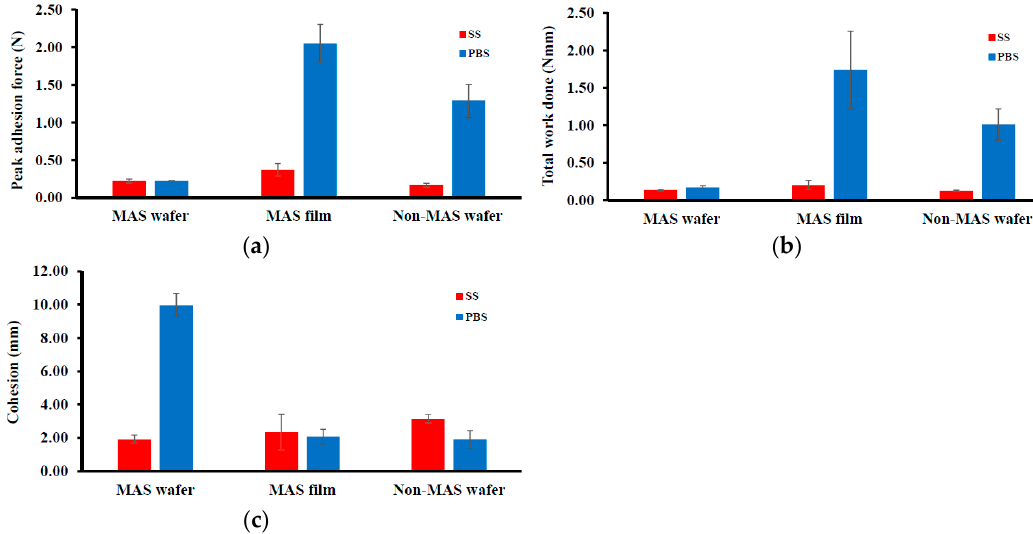
Figure 3. Differences in mucoadhesive profiles of optimized wafers and films ( n = 3, ± SD) in PBS and SS: ( a ) peak adhesive force (N), ( b ) total work done (N mm), ( c ) cohesiveness (mm).